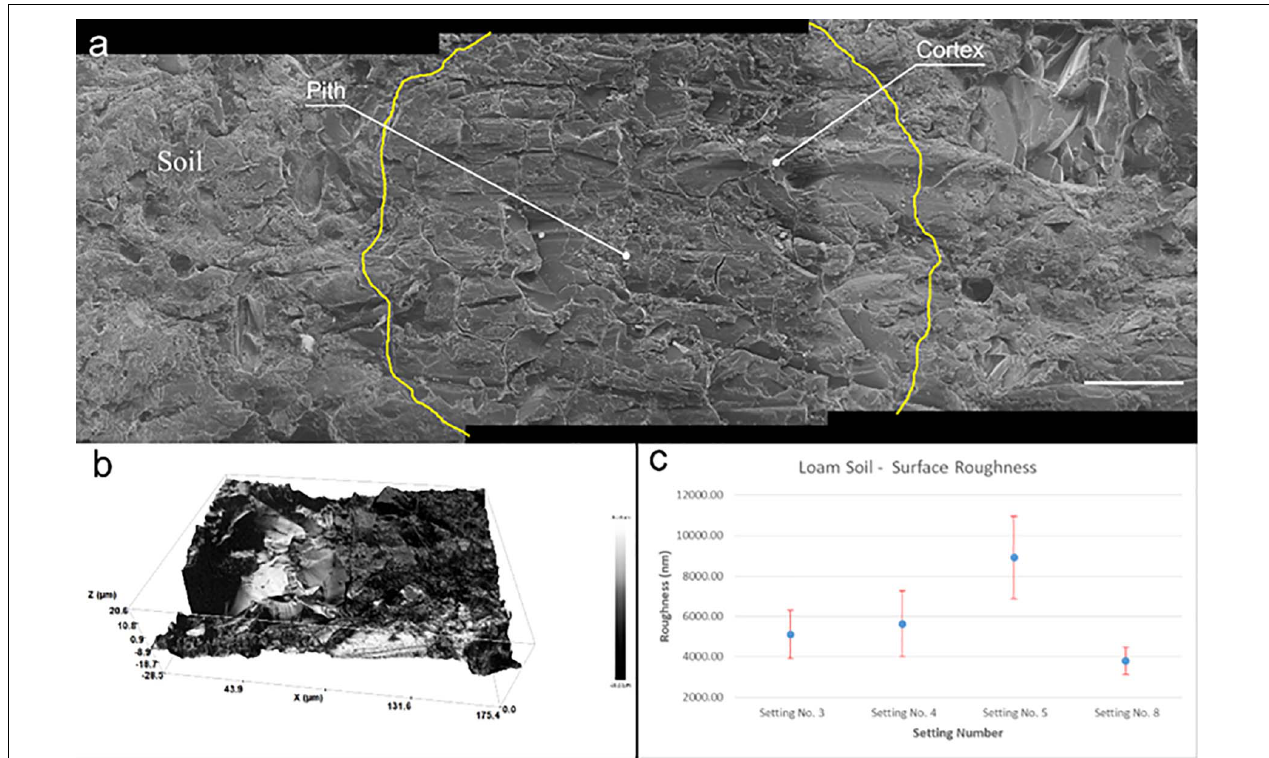
FIGURE 2 | Surface roughness of embedded soil sample. (a) Three helium ion micrographs are stitched showing the quality of embedding and surface roughness of a root after water jet cutting. Root cell is located in the middle image and outlined in yellow for easy recognition. Root cells and soil-mineral interface are well infiltrated by the embedding procedure. Scale bar 50 µ m (b) Surface profile of a root area measured by profilometer before microscopy. Rz = 49.8 µ m (c) Resulted surface roughness of embedded soil once cut with different parameters by